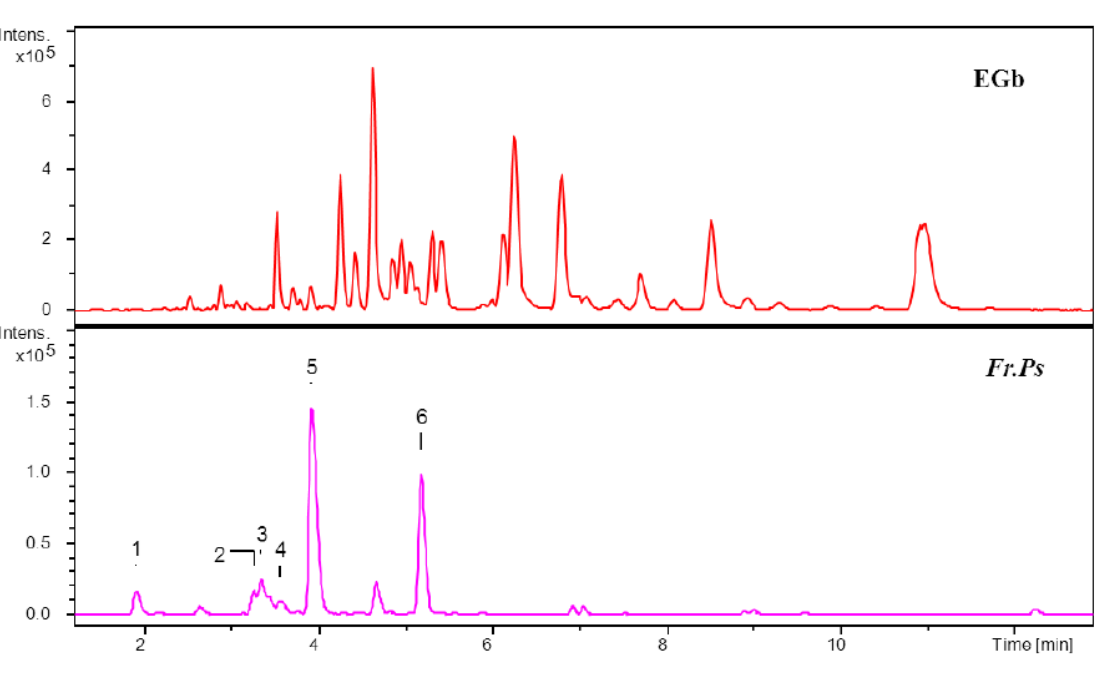
Figure 4. Total ion chromatograms (TIC) of the total extract of ginkgo leaves and the fraction enriched in catechins and procyanidins ( Fr. Ps ). (1: GC, 2: P-B 5: C, 6: